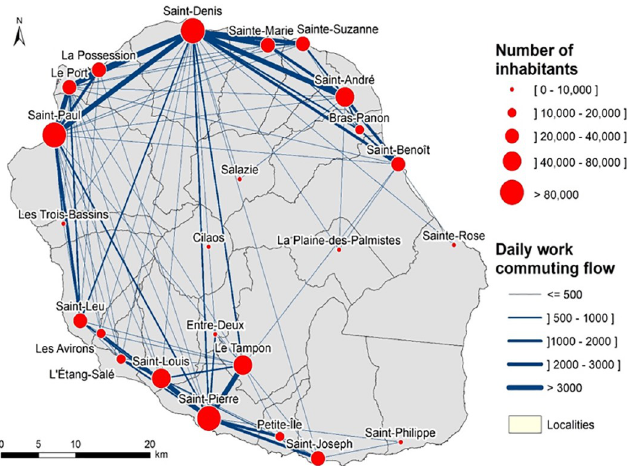
Fig 3. Population and daily commuting mobilities, Reunion Island, 2016. Population and daily commuting mobilities, Reunion Island, 2016. Census and mobility data are open data available from https://www.insee.fr/fr/ statistiques; base map: French national geographic institute, BD TOPO—data available under the open license Etalab 2.0 (https://geoservices.ign.fr/bdtopo).